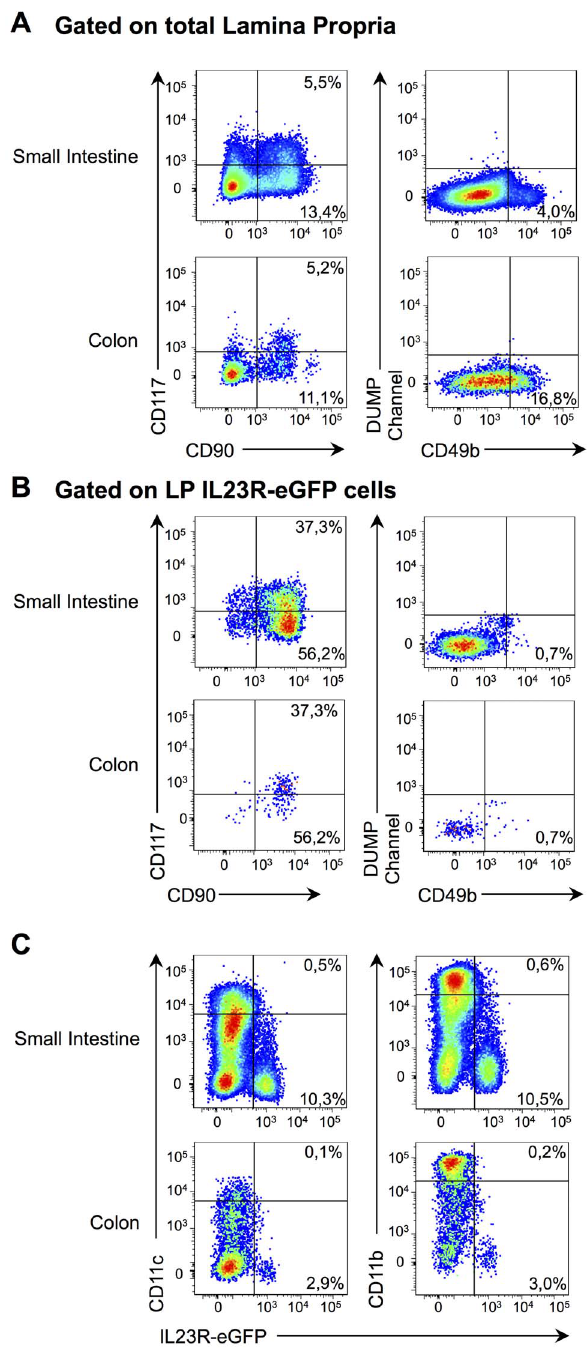
Figure 8. The anti-CD40-induced inflammatory response does not alter the distribution of immune cells in the gut-associated lymphoid tissue. IL-23R-eGFP 2 / 2 .Rag1 2 / 2 mice were treated with anti-CD40 and the intestines were processed at day 2. (A) The extracellular staining strategy for the identification of innate lymphoid cells (CD117 + CD90 + ) and NK cells (CD49b) within total cells in the lamina propria of the small intestine and colon. Electronic gating of viable hematopoietic cells was achieved by using the viable exclusion dye and CD45 expression. (B) Identification of IL-23R-eGFP + immune cell subsets from IL-23R-eGFP 2 / 2 .Rag1 2 / 2 anti-CD40-treated mice based on the strategy defined in A. (C) Flow cytometry profiles of IL- 23R-eGFP expression in CD11c and CD11b expressing cells.